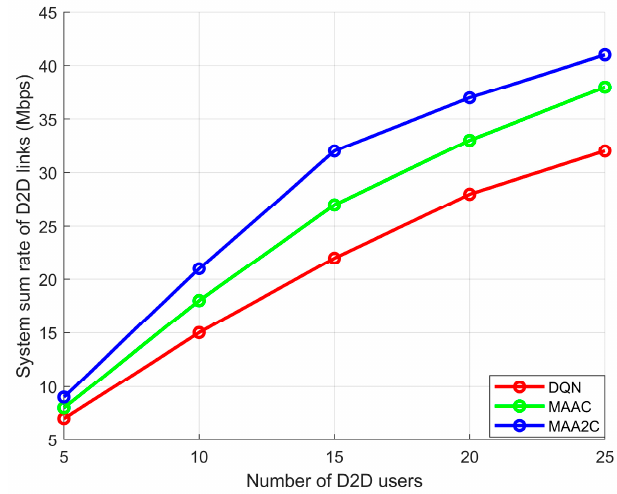
Figure 8. System sum rate of D2D links (Mbps).